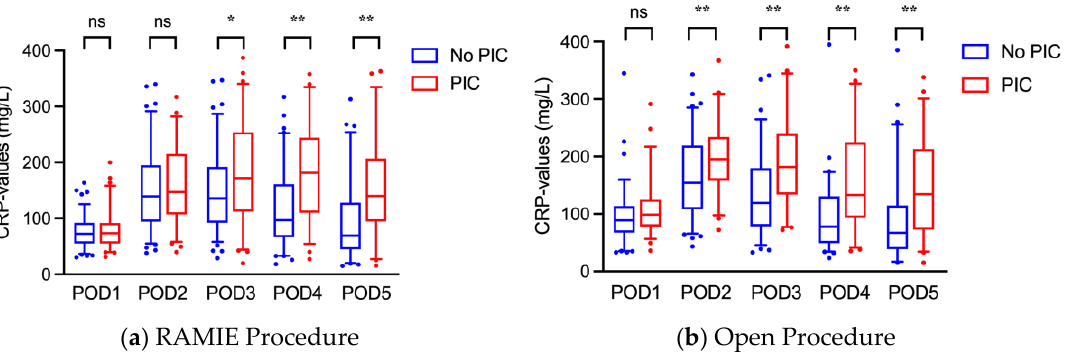
Figure 1. Flow-Chart of the inclusion of the study. HMIE: Hybrid minimally invasive esophagectomy, MIE: minimally invasive esophagectomy, NonPic: non-postoperative infectious complications, PIC: postoperative infectious complications, RAMIE: Robot-assisted minimally invasive esophagectomy, OE: open esophagectomy.